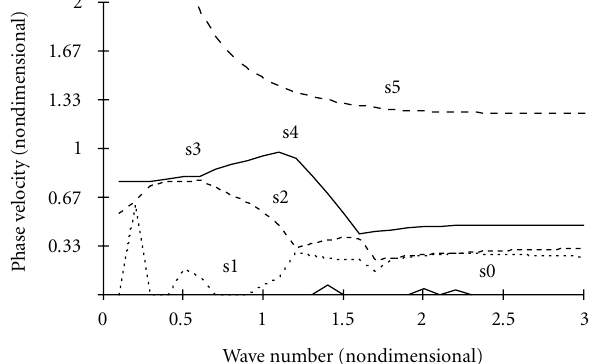
Figure 8.6. Dispersion of the first six extensional modes for τ 0 = 2 . 10 − 7 second and τ 1 = 2 . 10 − 6 second